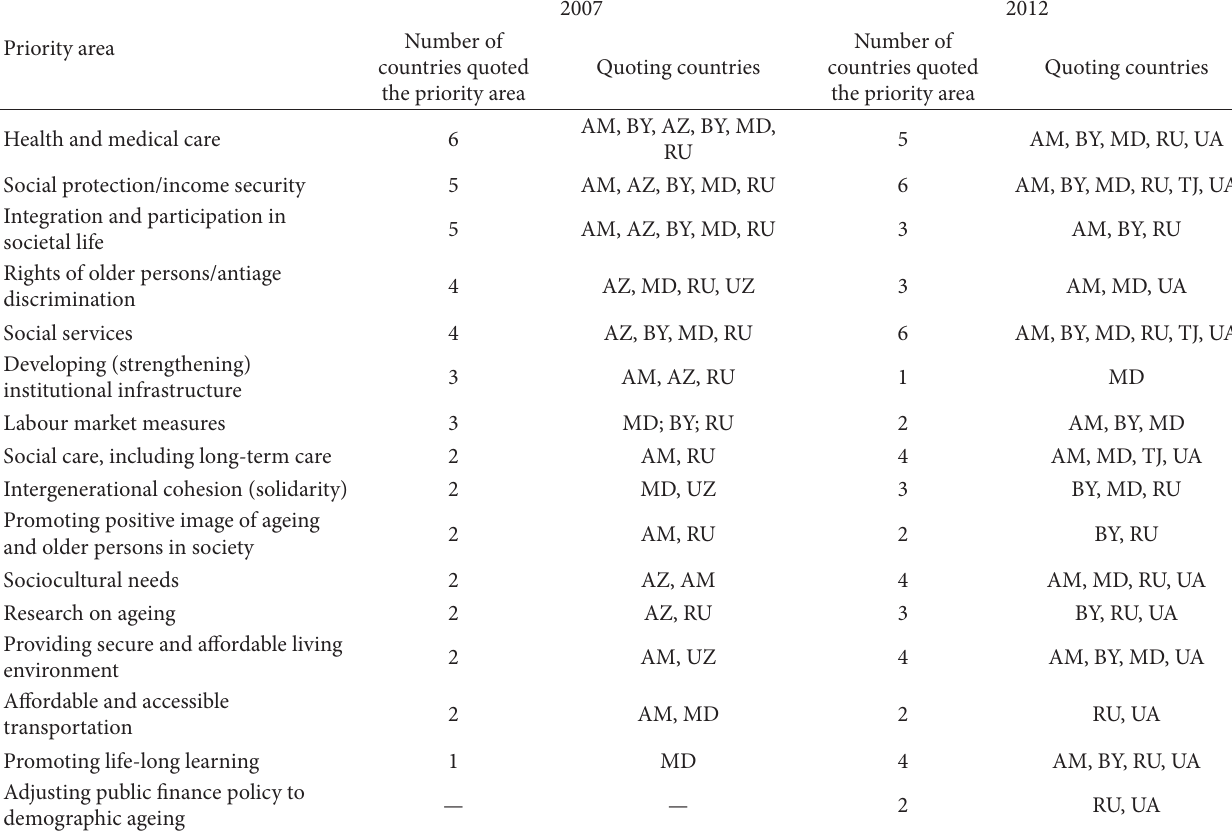
T 4: Areas of policy priorities on ageing in CIS countries, 2007,